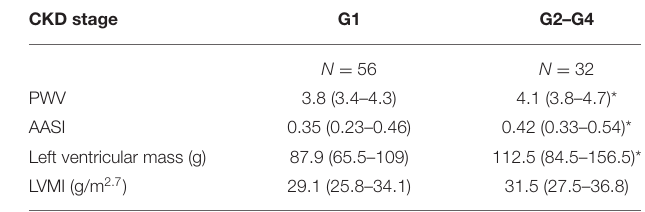
TABLE 3 | Plasma levels of apolipoprotein C-II, C-III, and lipids of study population ( n = 88).